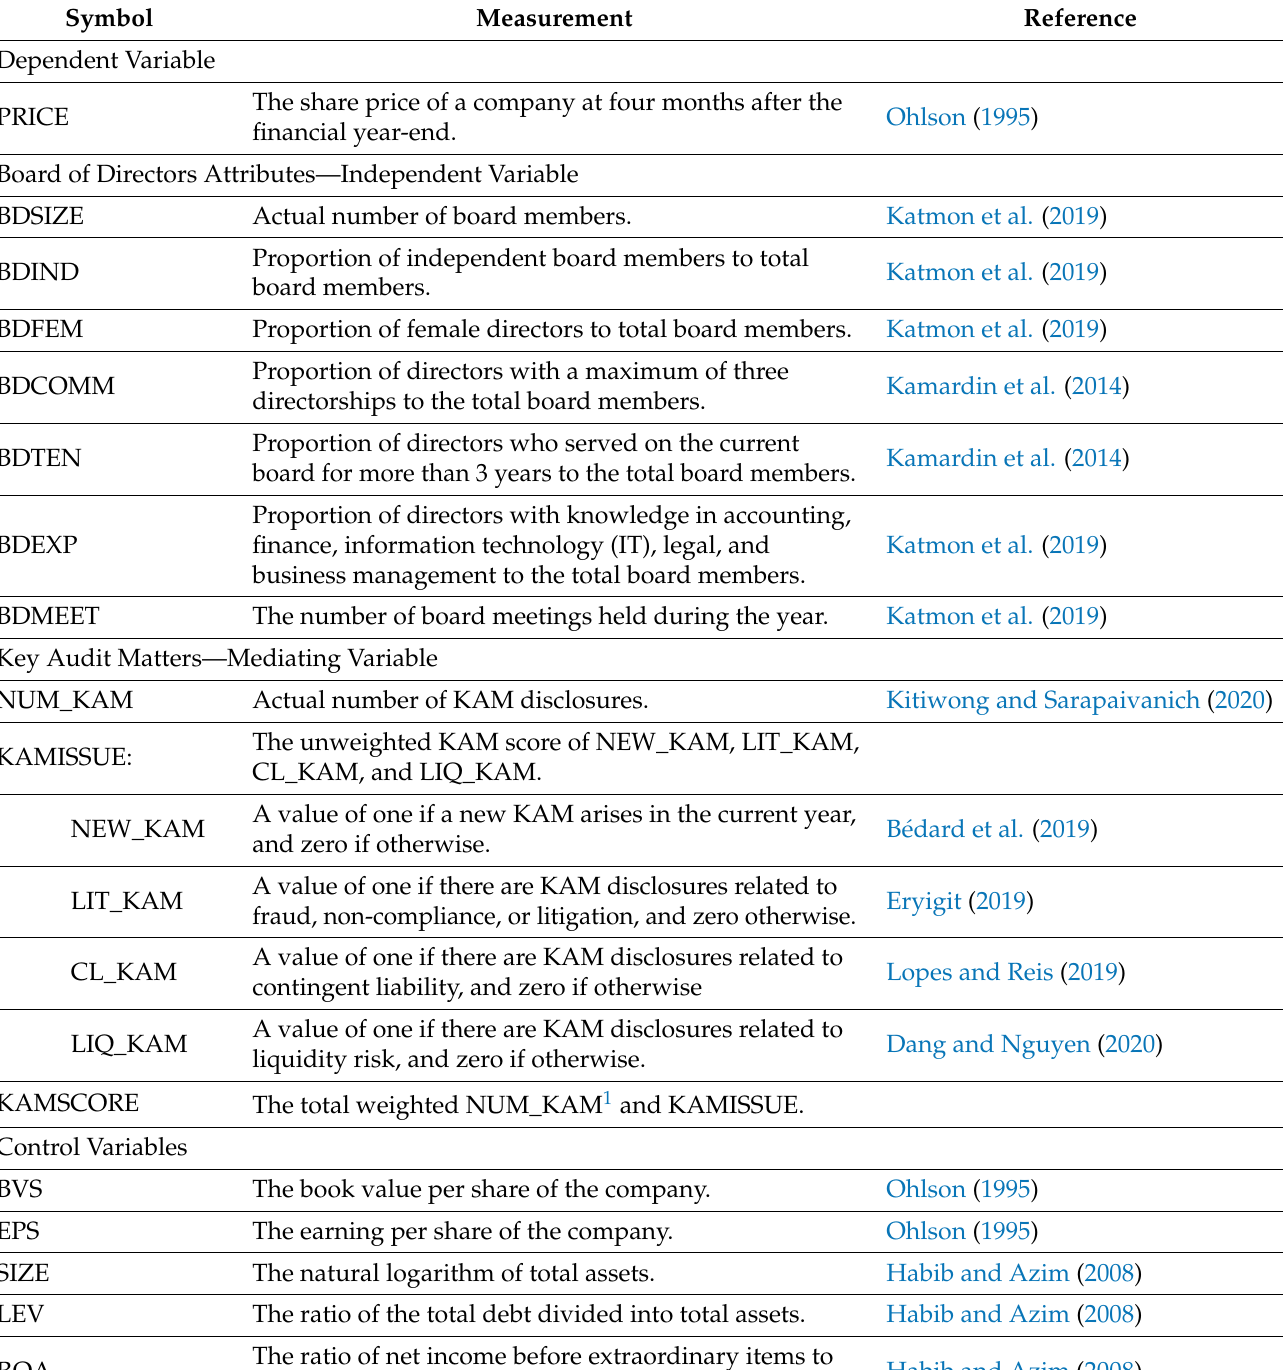
Table 2. Measurement of